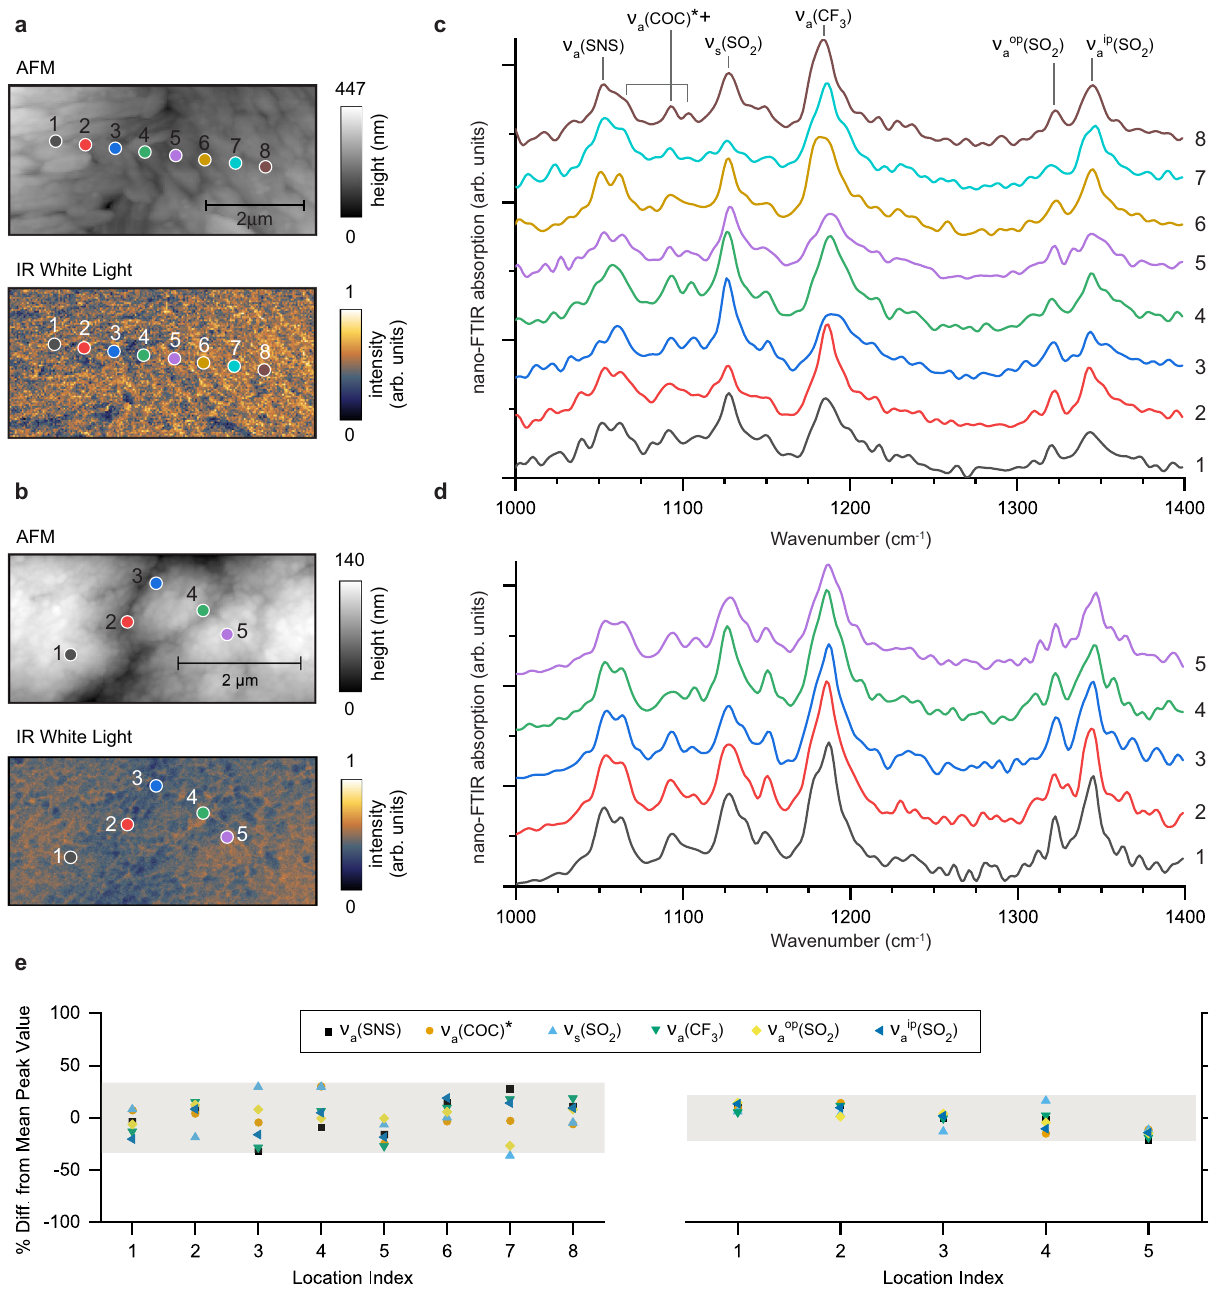
Fig. 2 Characterization of the pristine G/SPE interface at room temperature and after heating to 45 °C. Atomic force microscopy (AFM), infrared (IR) white light images, and local nano-FTIR spectra at room temperature ( a and c ) and after heating to 45 °C ( b and d ). e Scatterplots of six IR bands as a percentage of mean peak height at room temperature and 45 °C, plotted as a function of probing location. Overlaid shadowed areas indicate plus/minus two standard deviations for data